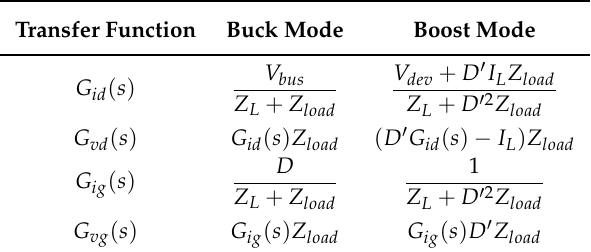
Table 2. The derivations of G id ( s ) , G vd ( s ) , G ig ( s ) and G vg ( s )